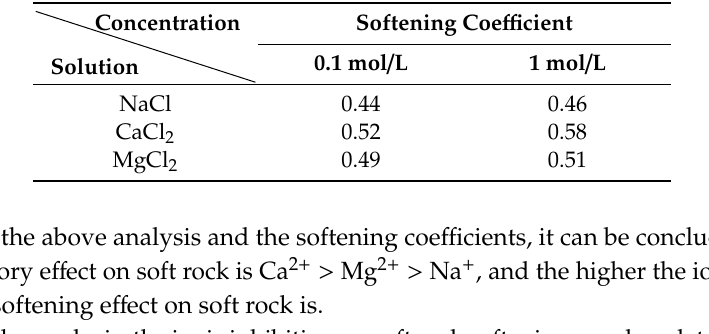
Table 4. Softening coe ffi cient comparison